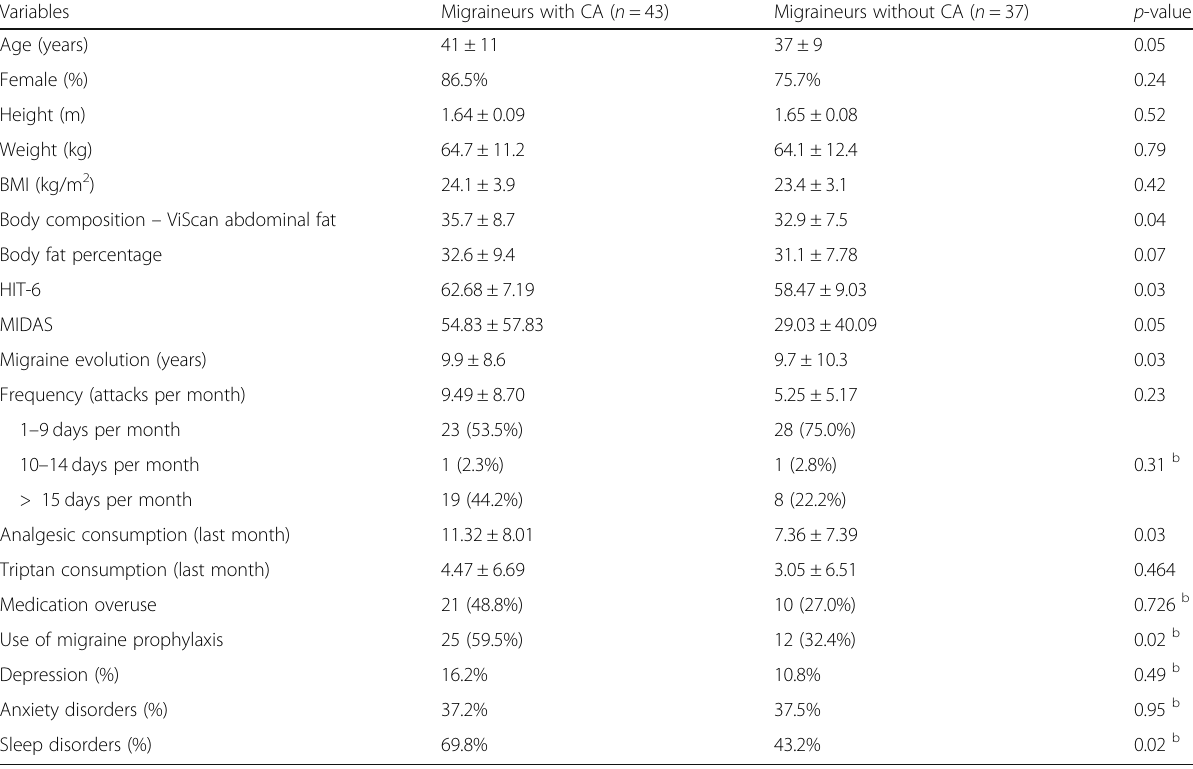
Table 2 Anthropometric and clinical characteristics in migraine patients with and without cutaneous allodynia Variables Migraineurs with CA ( n = 43) Migraineurs without CA ( n =